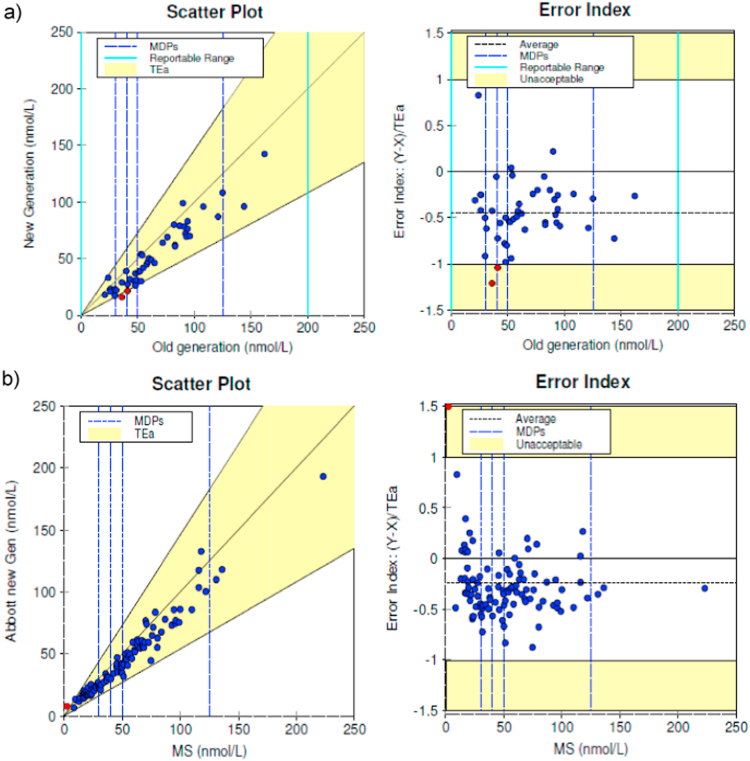
Two instrument comparisons between (a) the new (5P02) and old (3L52) generation of Architect 25OHD methods and (b) the new Architect 25OHD and LC-MS/MS(MS). The regression line for 47 samples (a), calculated according to Deming, is indicated (25OHD new generation nmol/L =0.87 × (25OHD old generation) nmol/L −4.9 nmol/L, r2=0.95). The regression line for 100 samples (b), calculated according to Deming, is indicated (25OHD new generation nmol/L =0.88 x (total 25OHD MS) nmol/L −1.2 nmol/L, r2=0.98). The difference between the two methods was within total allowable error (TEa) of 46%. The methods produced clinically equivalent results. Results covered the medical decision points (MDPs) of 30, 40, 50 and 125 nmol/L.